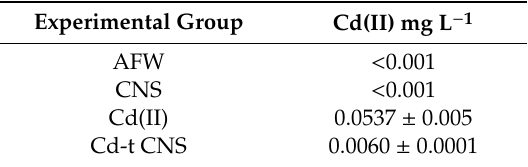
Table 1. Cd(II) concentration (mg L − 1 ) measured by plasma spectroscopy in treatment waters after 48 h of exposure to the following experimental groups: artificial freshwater (AFW) (control); Cd(II) (0.05 mg L − 1 of CdCl 2 in AFW); Cd-t CNS (CdCl 2 0.05 mg L − 1 contaminated AFW treated with CNS); CNS (AFW treated with only